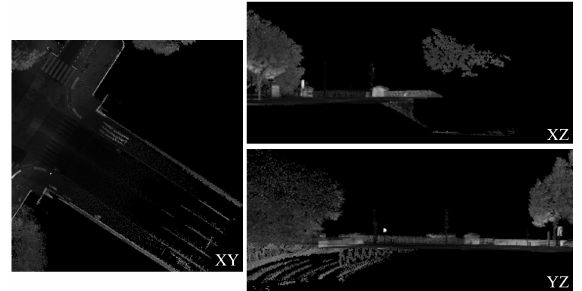
Figure 7. The three images produced from the point cloud set of Figure 1a illustrating intensity values.